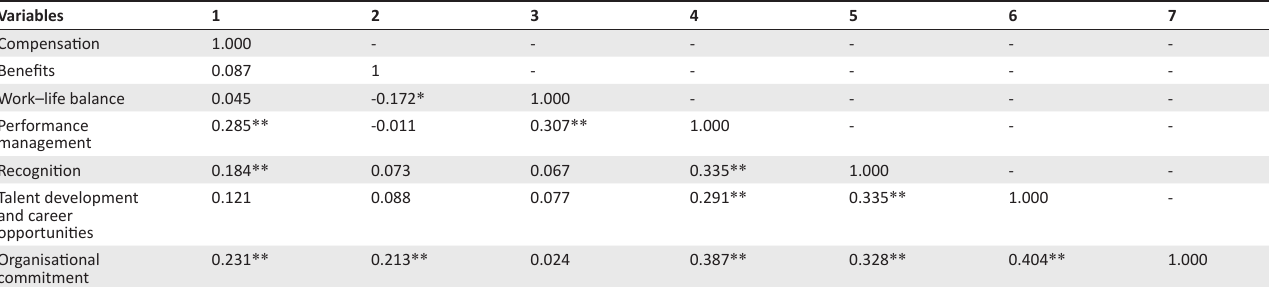
TABLE 2: Significant Pearson